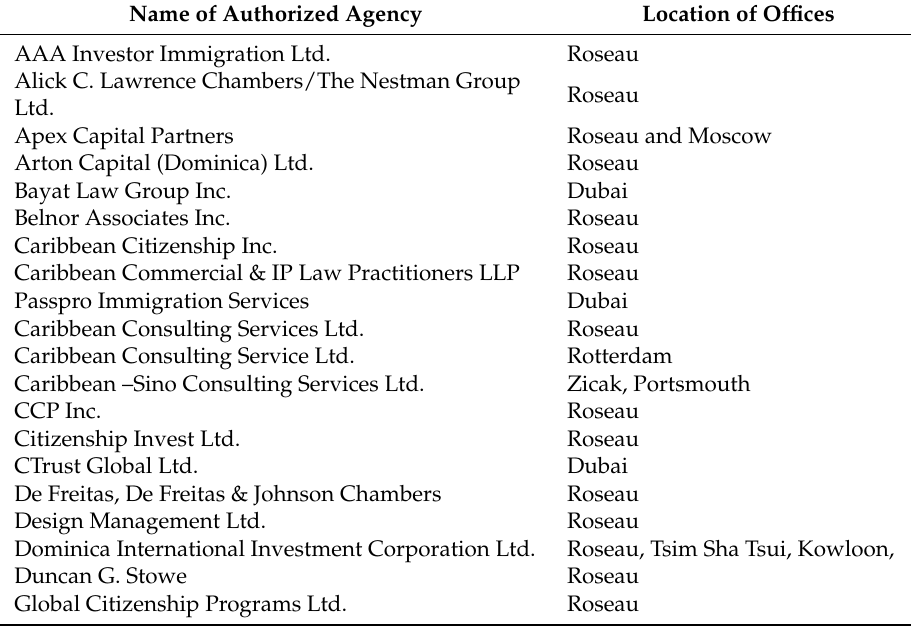
Table 1. List of Authorized Agencies by location of